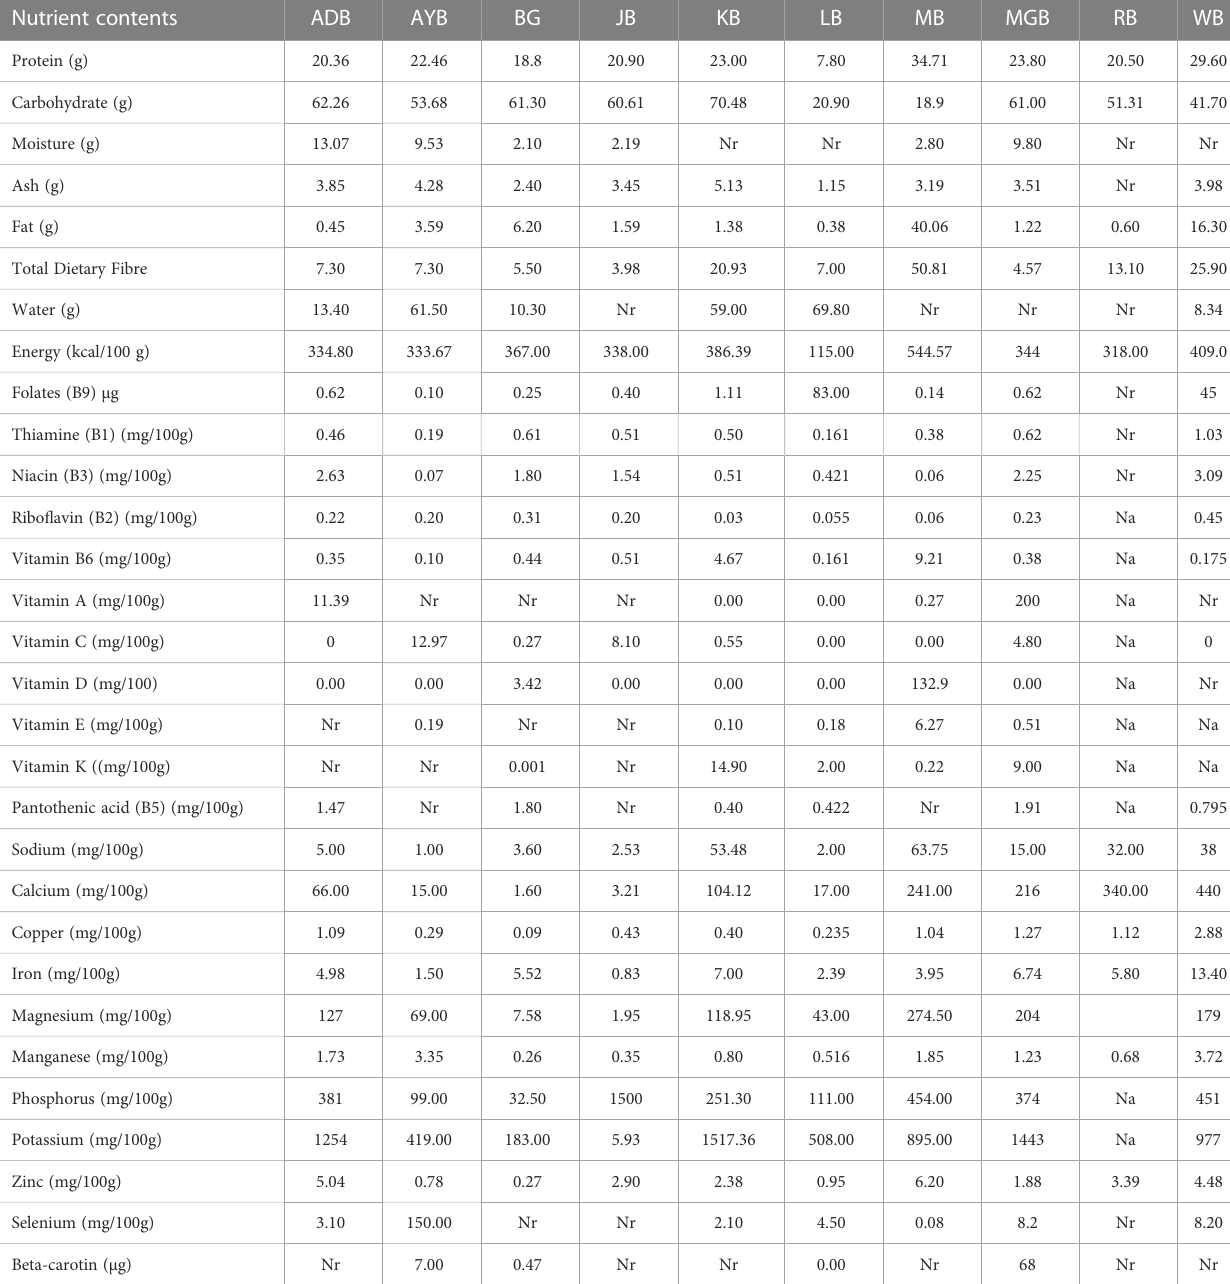
TABLE 2 Nutritional composition of the selected underutilized legumes' raw, mature seeds, with values per